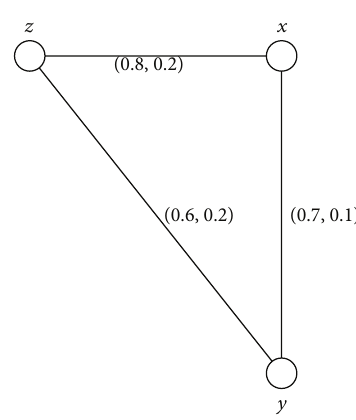
Figure 3: Connected intuitionistic fuzzy graph.